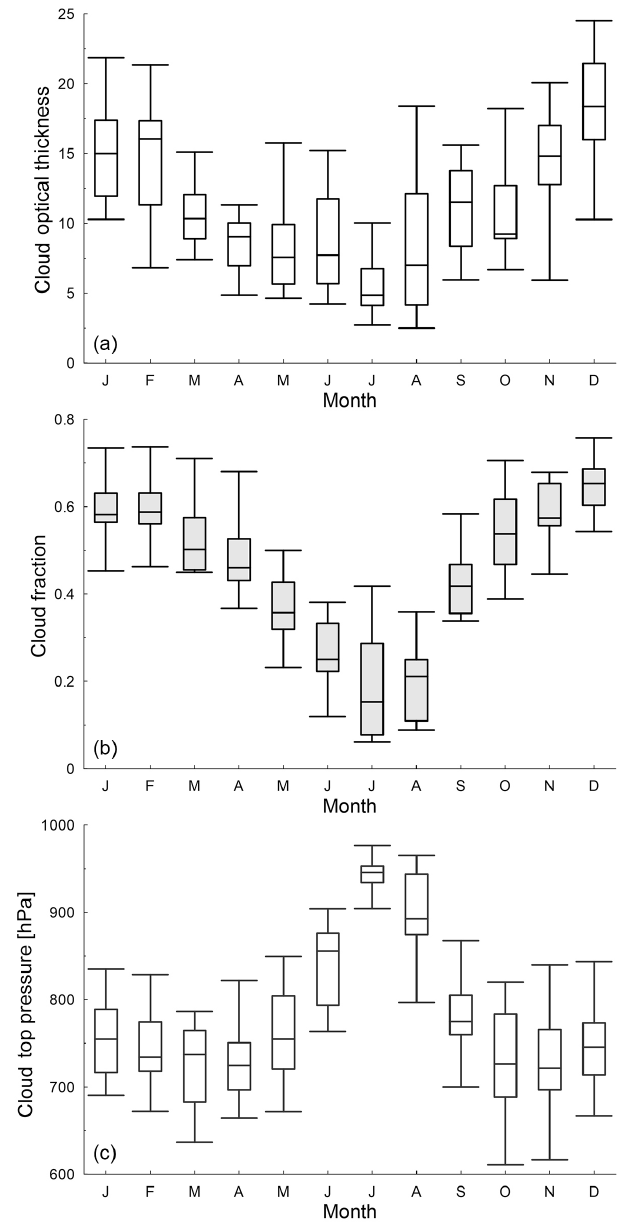
Figure 10. Annual evolution of monthly averages of cloud optical thickness (a) , cloud fraction (b) , and cloud top pressure as derived from MODIS Aqua between July 2002 and December 2016. Maxi- mum, upper quartile, median, lower quartile, and minimum are dis- played for each